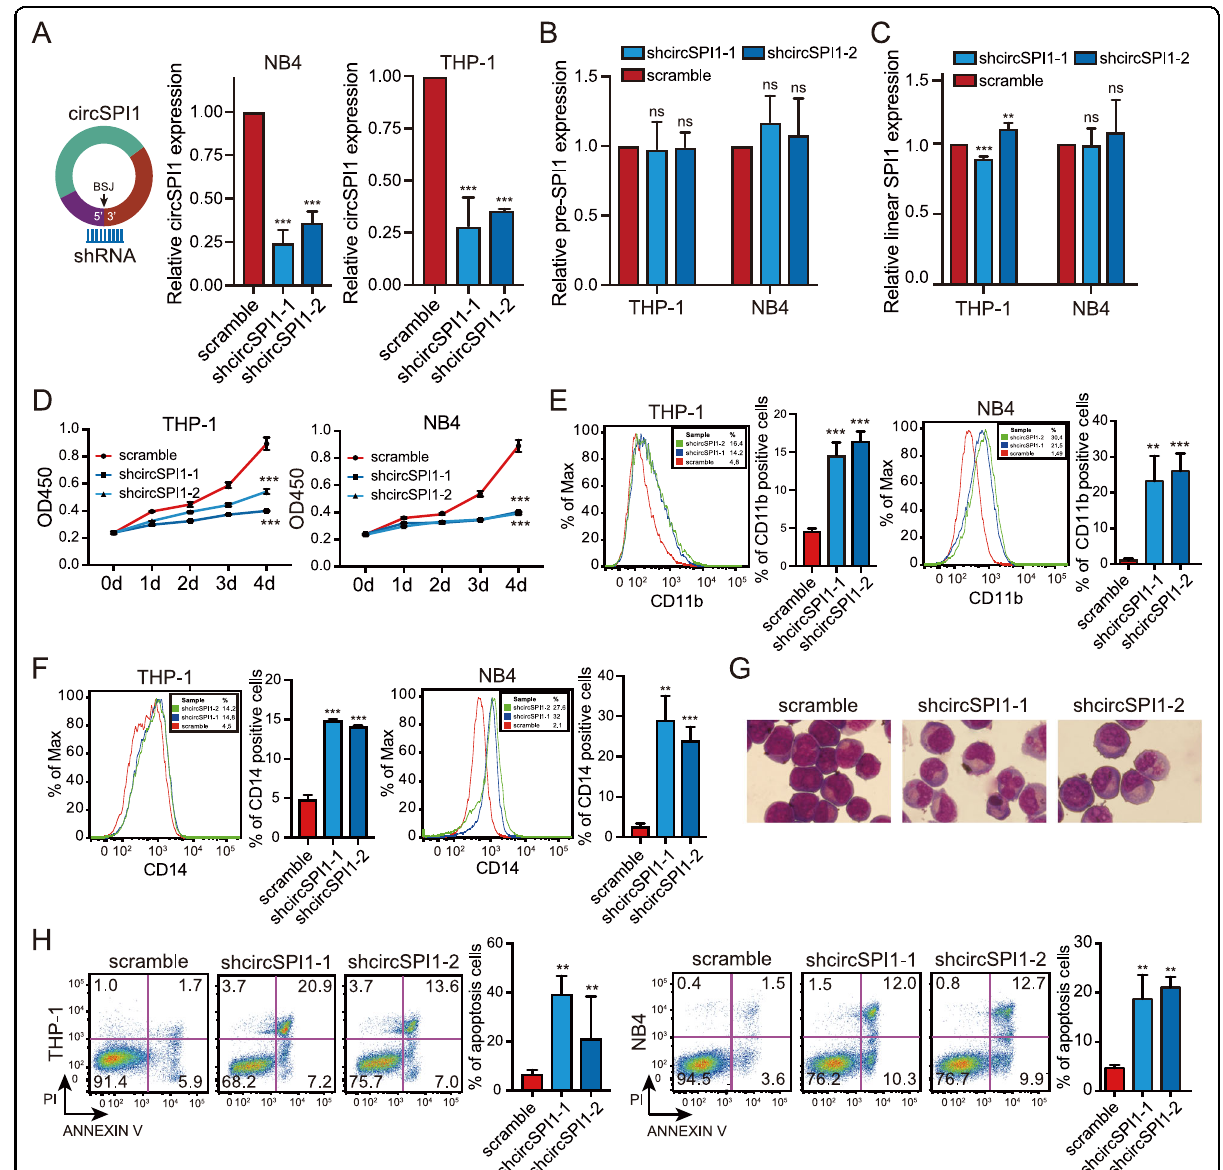
Fig. 3 CircSPI1 plays an oncogenic role in AML cells. A – C The knockdown ef fi ciency of shcircSPI1 was analyzed in THP-1 and NB4 cells. The expression of circSPI1 ( A ), pre-SPI1 ( B ), and linear SPI1 ( C ) was demonstrated by RT-qPCR after infected with shcircSPI1 or scramble lentiviruses in THP- 1 and NB4 cells. D – H CircSPI1 knockdown decreased proliferation, induced partial myeloid differentiation, and apoptosis in AML. THP-1 and NB4 cells were infected with shcircSPI1 or scramble lentiviruses. The cell proliferation ability was measured by the CCK8 assay 2 days after infection ( D ). Granulocytic ( E ) and monocytic ( F ) differentiation, cytomorphology ( G ), and apoptosis ( H ) were analyzed on day 4 after infection. Representative plots (left) and statistical percentage (right) of CD11b + , CD14 + , or Annexin V + /PI + / − cells are shown. Cell morphology was observed by Wright – Giemsa staining. All bar graphs represent the average of three independent replicates and error bars are SD, ** P < 0.01, *** P < 0.001, ns no signi fi